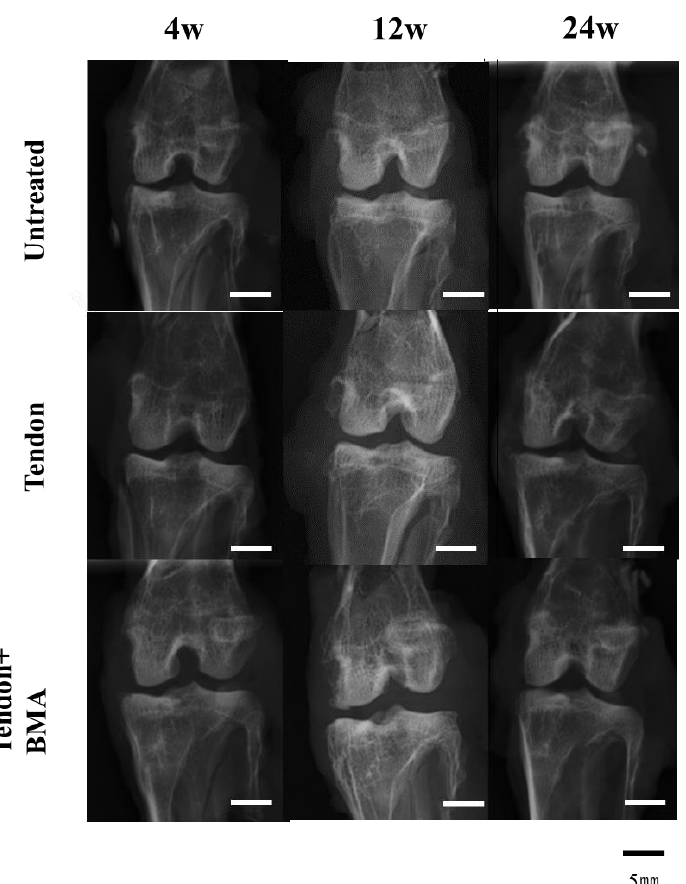
Figure 2. Radiographic analysis of the regenerated meniscus. No calcified change in the anteroposterior radiographs was noted in the tendon + BMA, tendon, or untreated groups over the experimental period of 24 weeks.